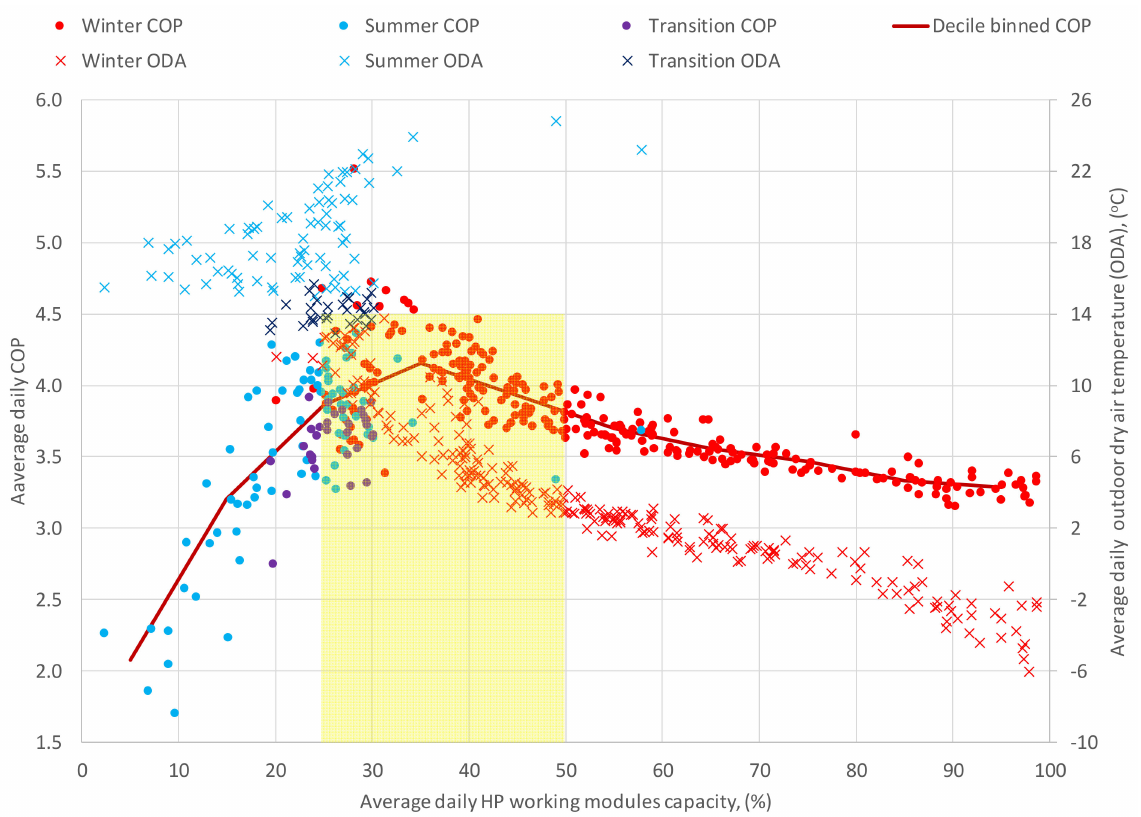
Figure 14. Heat pump’s COP and ODA in partial load